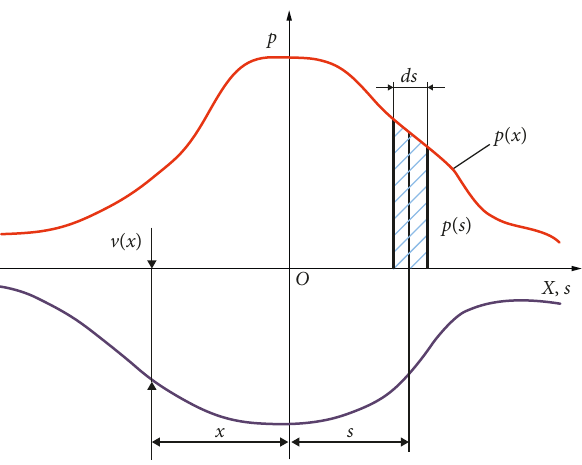
Figure 4: Schematic of line-load